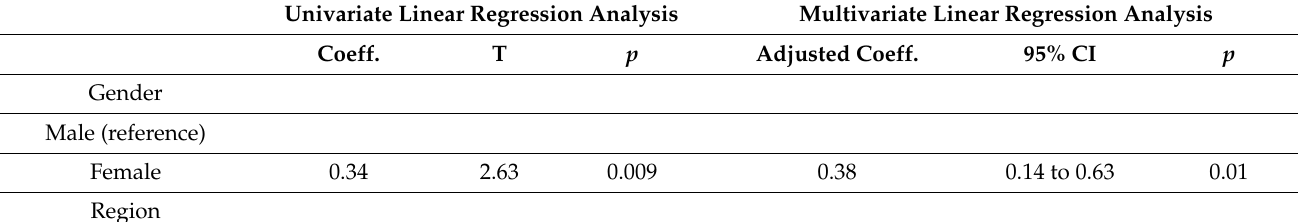
Table 5. Predictors of attitude scores (n = 2000). Univariate Linear Regression Analysis Multivariate Linear Regression Analysis